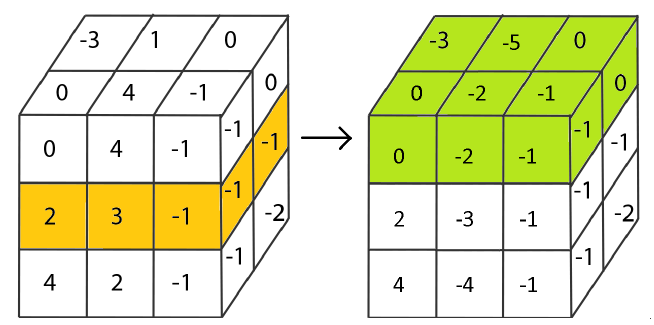
Figure A1. Column-block linearity analyses for Wald and Hurwicz criteria: change in the results via the 3D matrices A (on the left ) and ¯ A (on the right